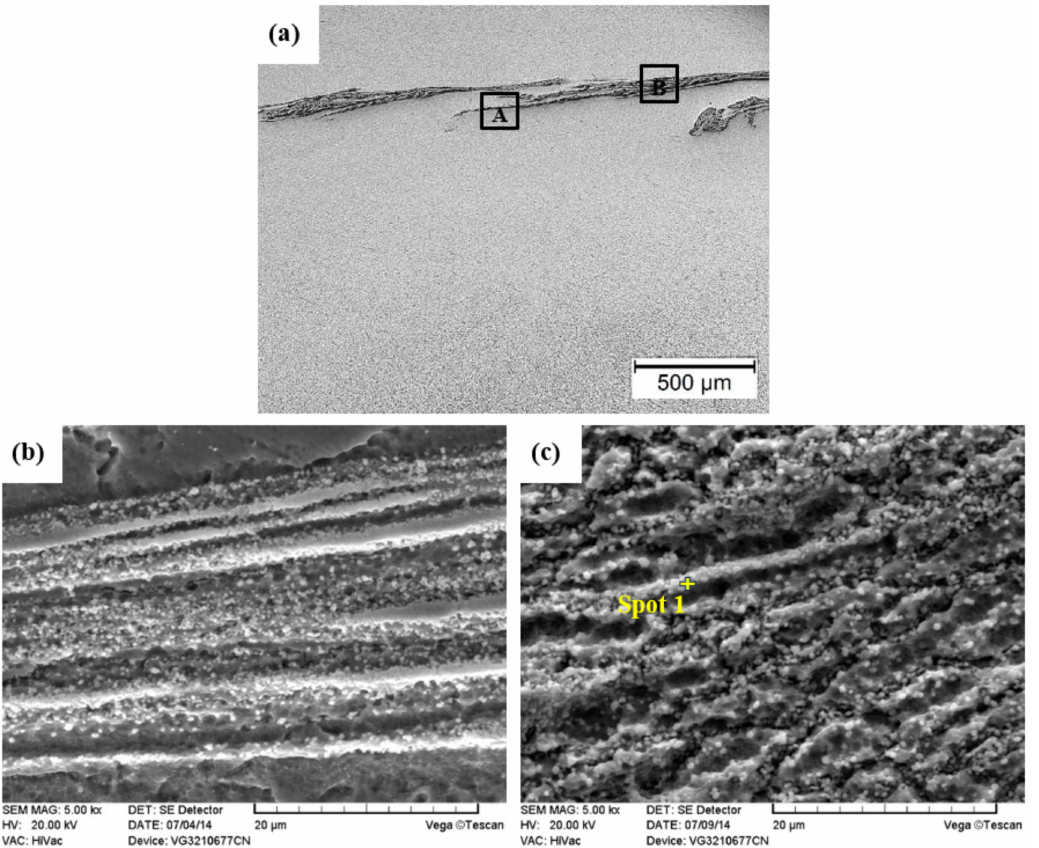
Figure 6. Microstructure of defect zone at the edge by: ( a ) OM at low magnification, ( b ) high magnification of zone A in ( a ) by SEM, and ( c ) high magnification of zone B in ( a ) by